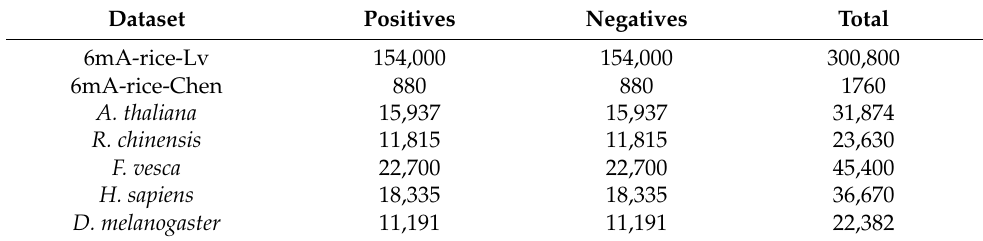
Table 1. Summary of seven benchmark datasets of six